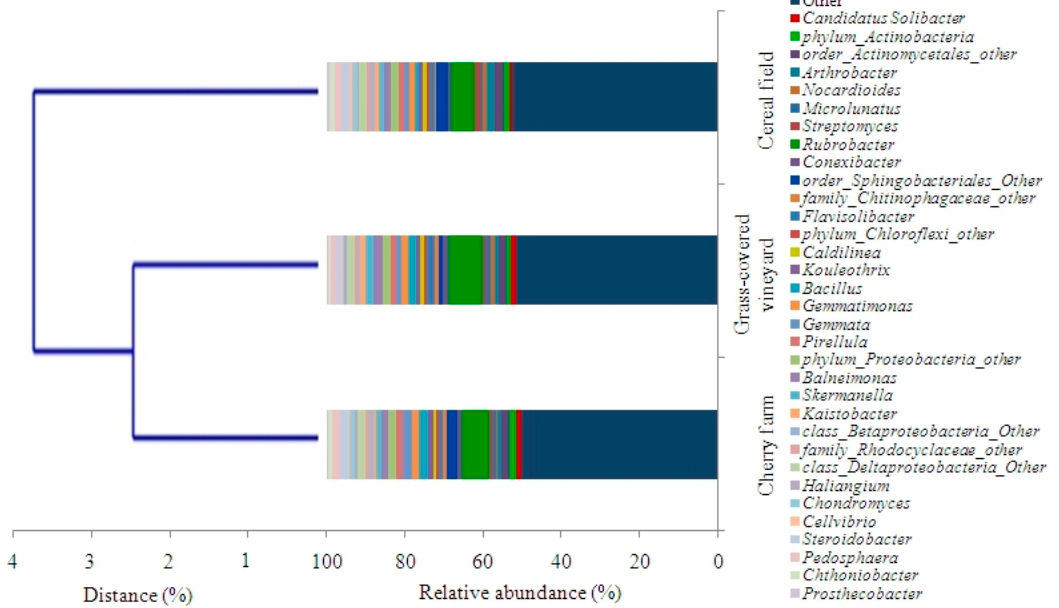
Figure 3. Analysis (Ward’s method) of the 16S rRNA composition of soil bacterial communities at the genera level. genera